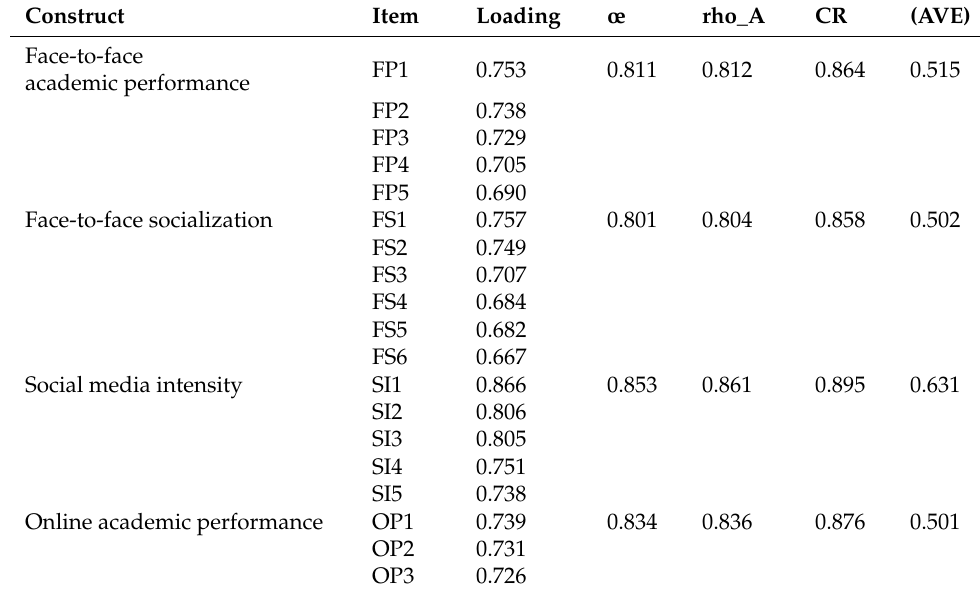
Table 2. Constructs’ validity and